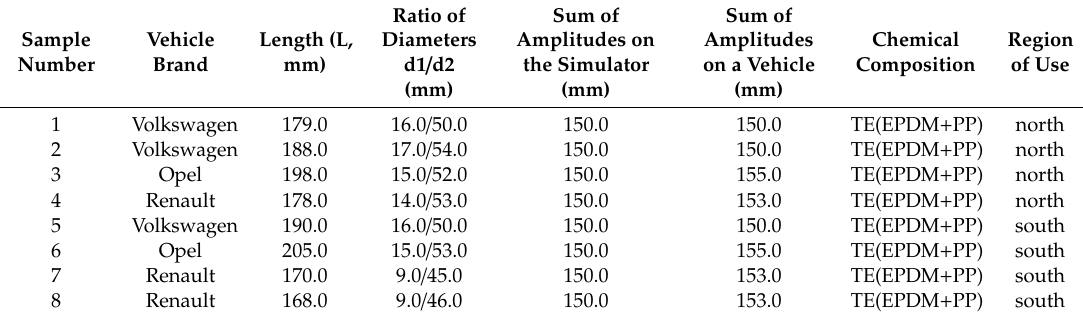
Table 2. The basic data of the first group of cu ff s before the start of testing.